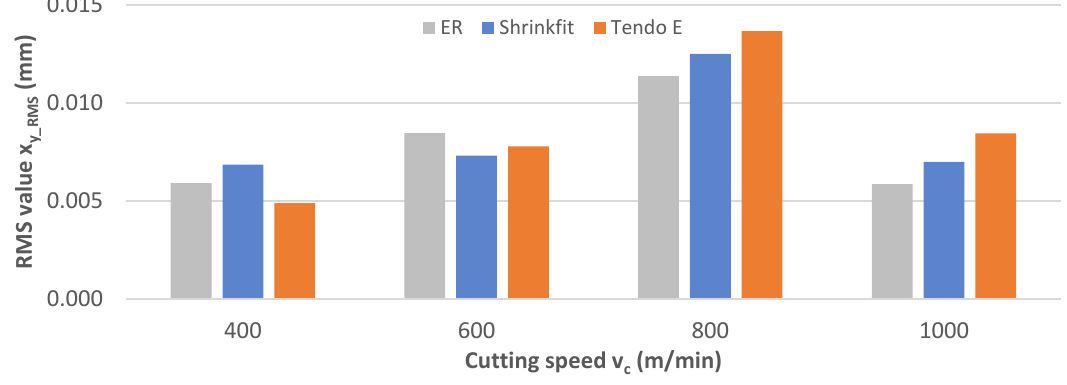
Figure 8. Impact of cutting speed v c on rms vibration displacement value x y_RMS (f z = 0.15 mm/tooth, a p = 6 mm). The impact of the feed per tooth on vibration displacement was tested over the range f z = 0.05–0.30 mm/tooth. The obtained maximum vibration displacement values x y are shown in Figure 9.